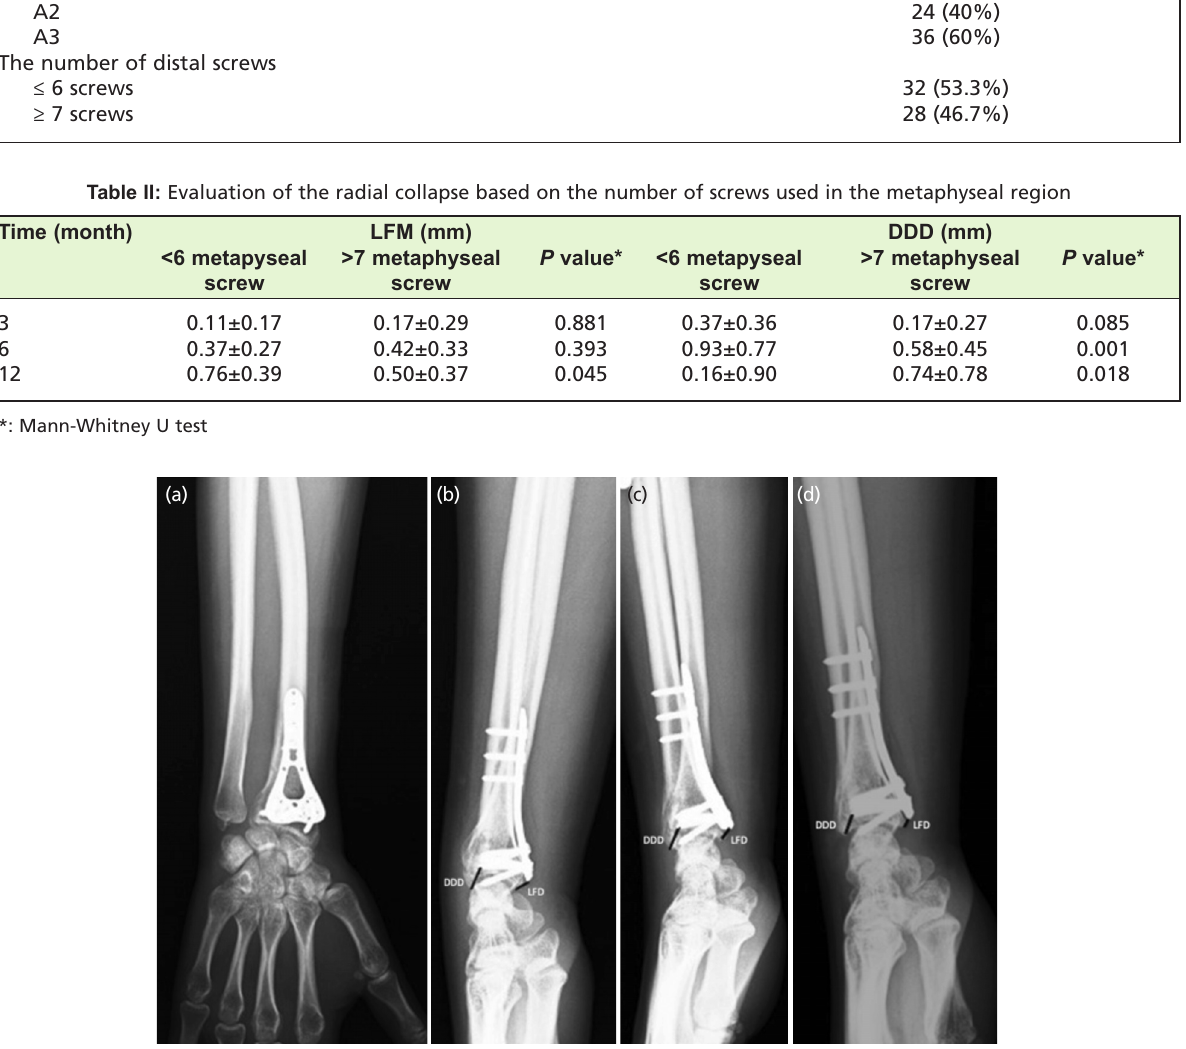
Fig. 1: Method of measuring the radiographic parameters of the distal radius fractures: Radial collapse was observed in the radiographs taken during the one-year follow-up period. (a, b) Antero-posterior and lateral view at the time of discharge. (c) Lateral radiograph after three months. (d) Lateral radiograph at one year